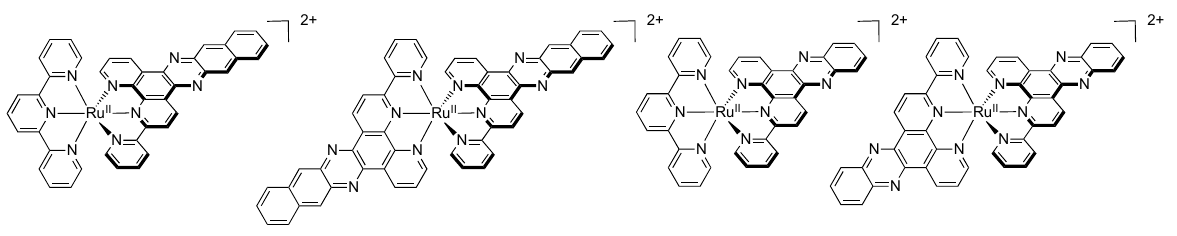
Figure 14. Ruthenium II complexes bearing a pydppn ligand (left) or a pydppz ligand